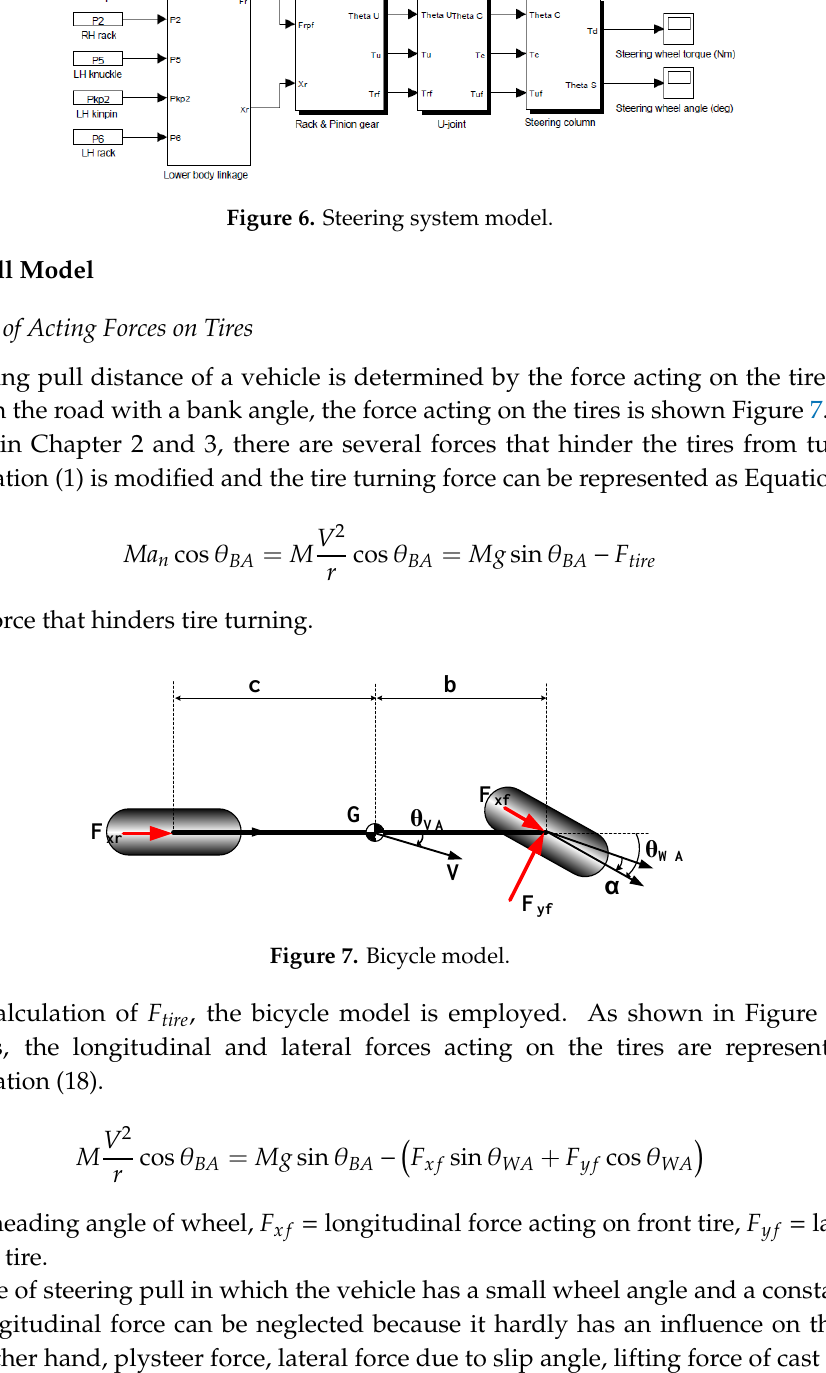
Figure 7. Bicycle model.